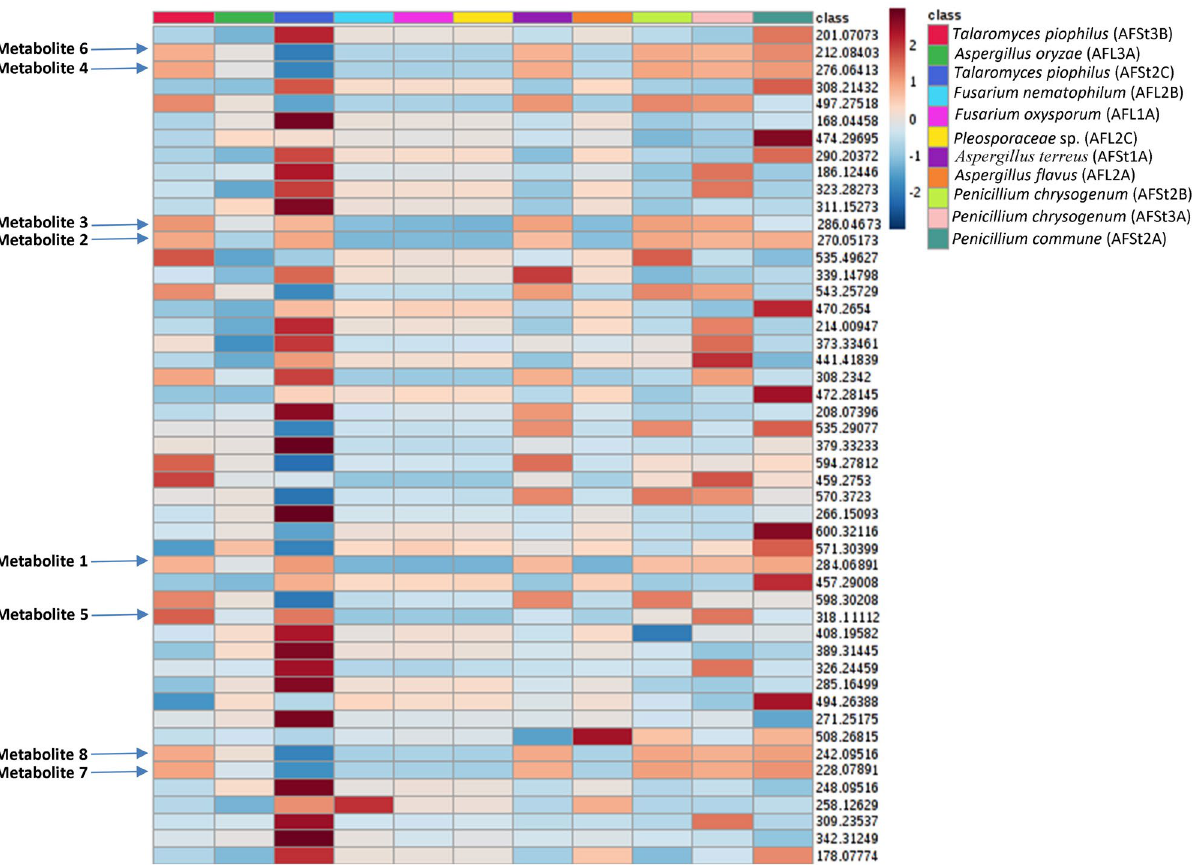
Figure 6. Heat-map indicating the distribution and abundance of main metabolites in the active antimalarial extracts including metabolites ( 1–8 ) that were highly correlated with this observed activity. The heat map was generated by MetaboAnalyst 4.0 28 (https ://www.metab oanal yst.ca/Metab oAnal yst/Modul eView .xhtml